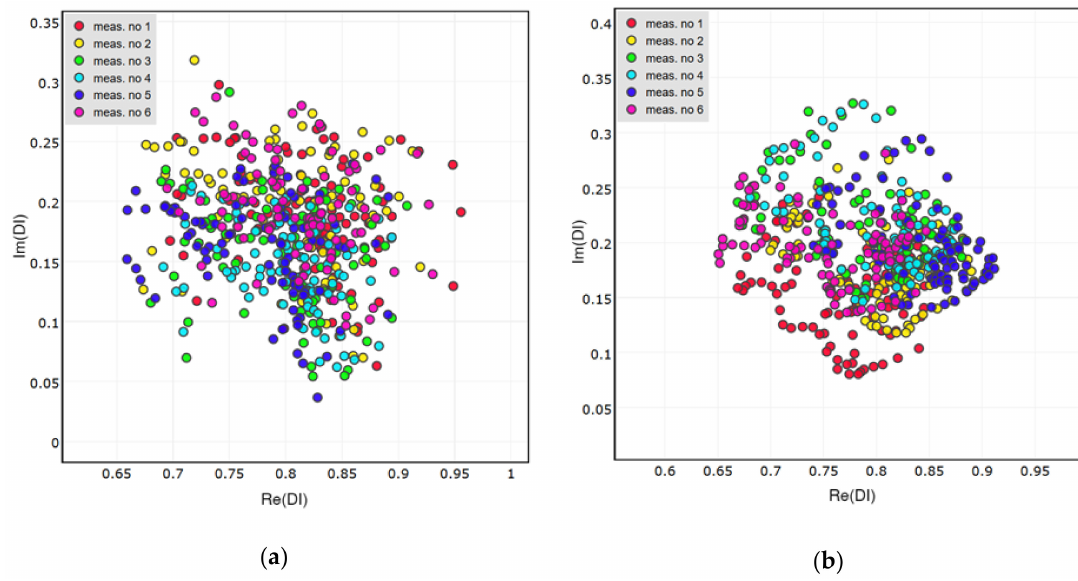
Figure 11. Damage Indices obtained for simulated damage on sensing path G-S1: ( a ) Attached network; ( b ) Embedded network.